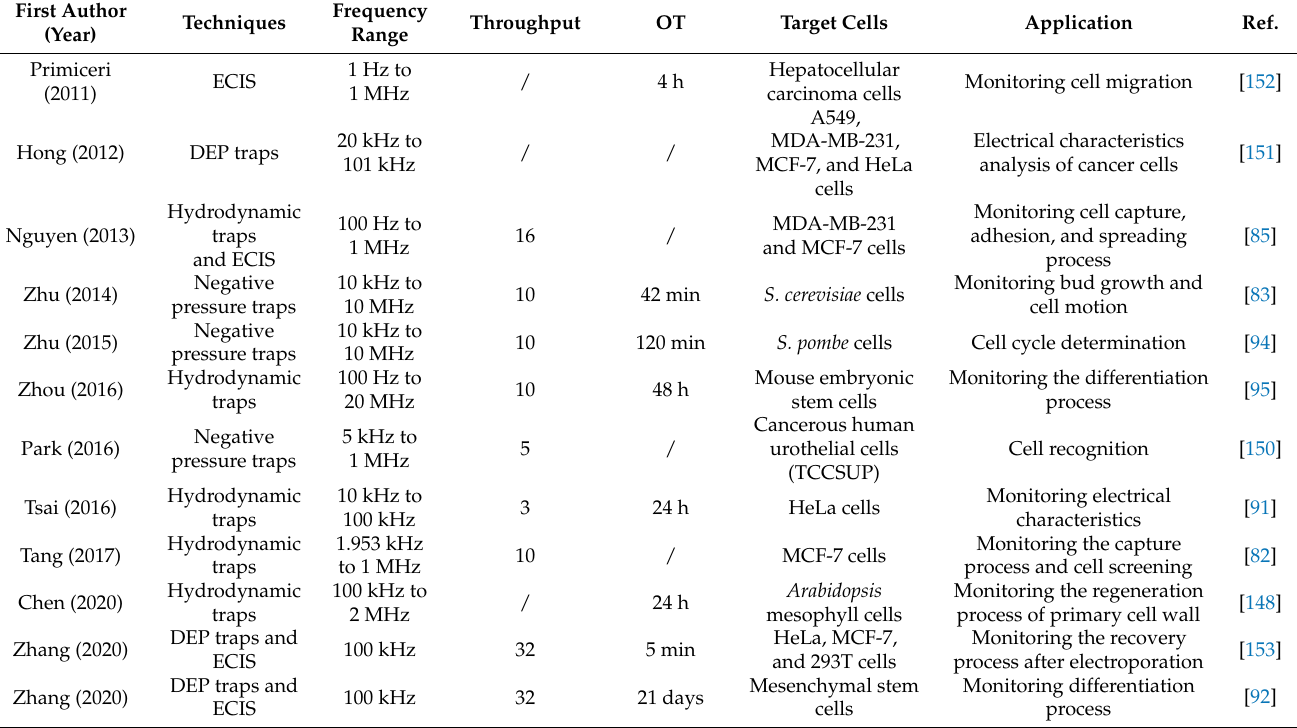
Table 2. Applications of EIS measurement for single cells. OT: Observation time. Throughput: Maximum number of single cells that can be simultaneously